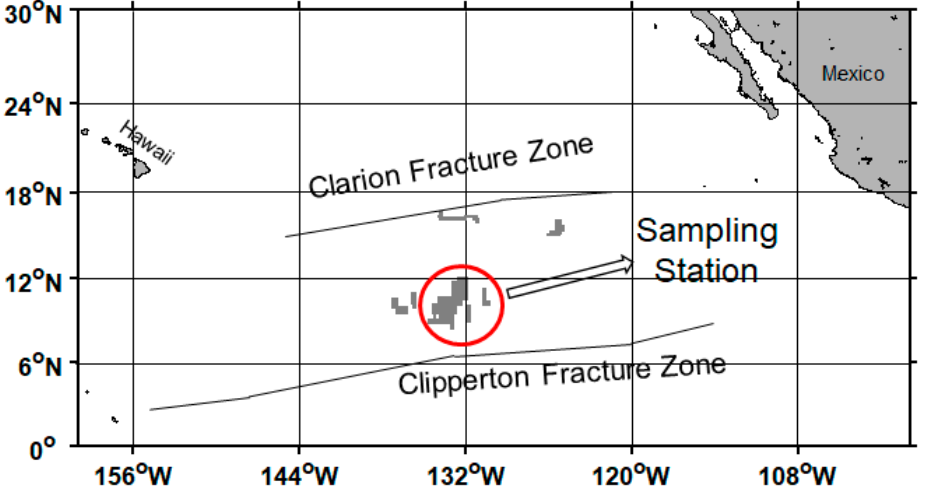
Figure 1. Manganese nodule sampling station of the Clarion-Clipperton Fracture Zone (CCFZ).